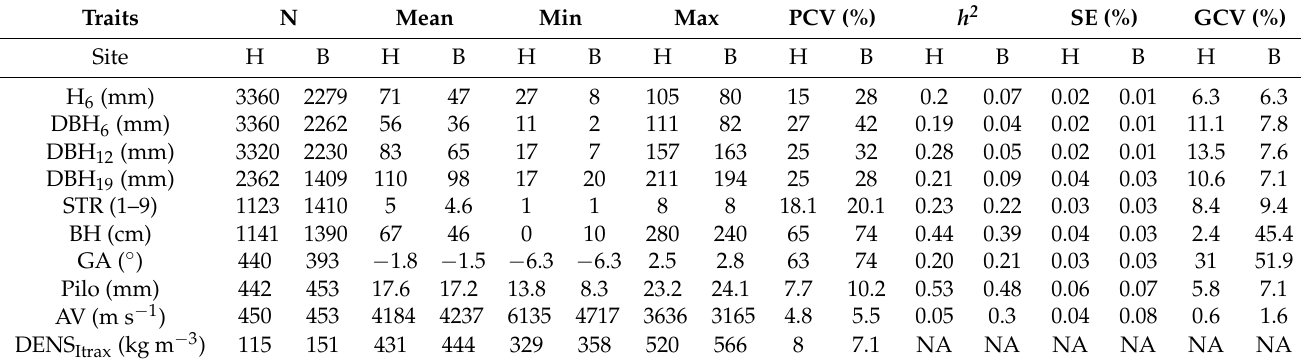
Brunsberg. PCVs were higher for Brunsberg (maximum 42%) than for Hyssna (maximum 27%), yet Hyssna had higher GCVs (maximum 13.5%) than Brunsberg (maximum 7.8%). Height at age 6 had the lowest coefficients of variation for any size trait, with PCV values of 15% at Hyssna and 28% at Brunsberg, and a GCV of 6.3% at both sites. Table 2. Measurements and units for manual, visual and non-destructive field assessments. Traits